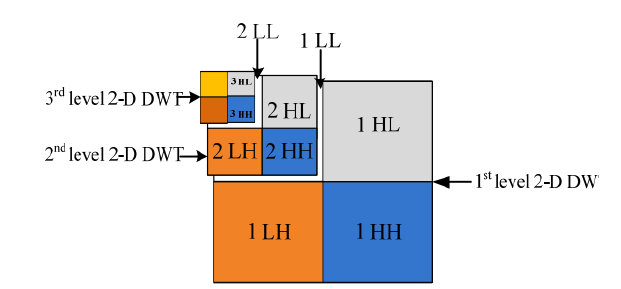
Figure 4. Multilevel Forward DWT